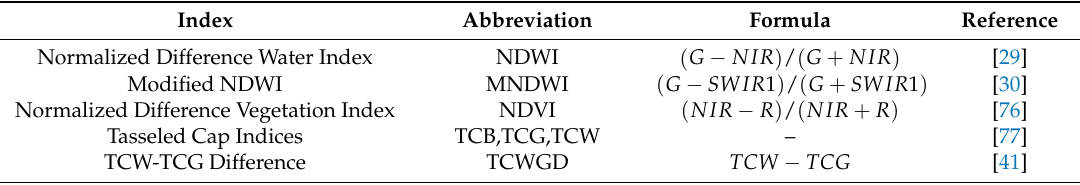
Figure 2. Flowchart of the SWF estimation algorithm demonstrated in this study. Spatial resolution of input, intermediate and final data products are shown in parentheses. An example of the aggregation step that produces a 150-m-resolution SWF layer is shown in the inset surrounded by dotted lines. Table 3. Spectral indices used (in addition to original spectral bands) to estimate SWF in this study. Spectral bands and abbreviations are listed in Table 1. Tasseled cap indices were computed using coefficients reported in Crist (1985).